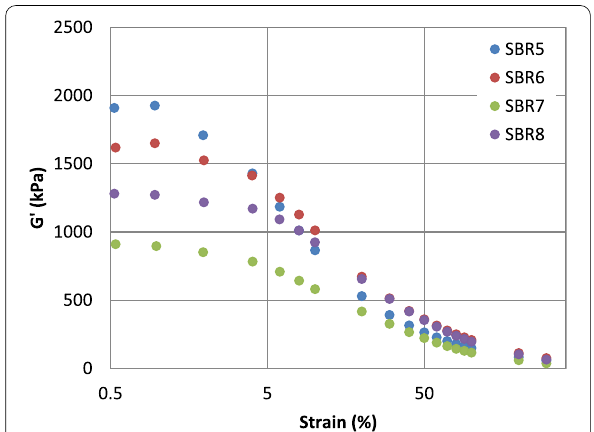
Fig. 11 Storage moduli at varying strains of silica–reinforced SBR compounds (branched